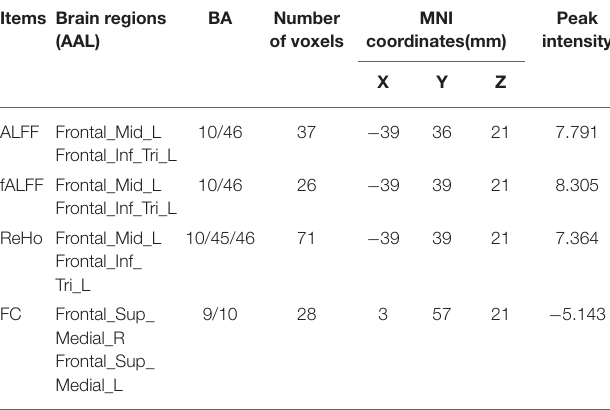
TABLE 3 | Brain changes after the first taVNS session ( N = 20). Items Brain regions